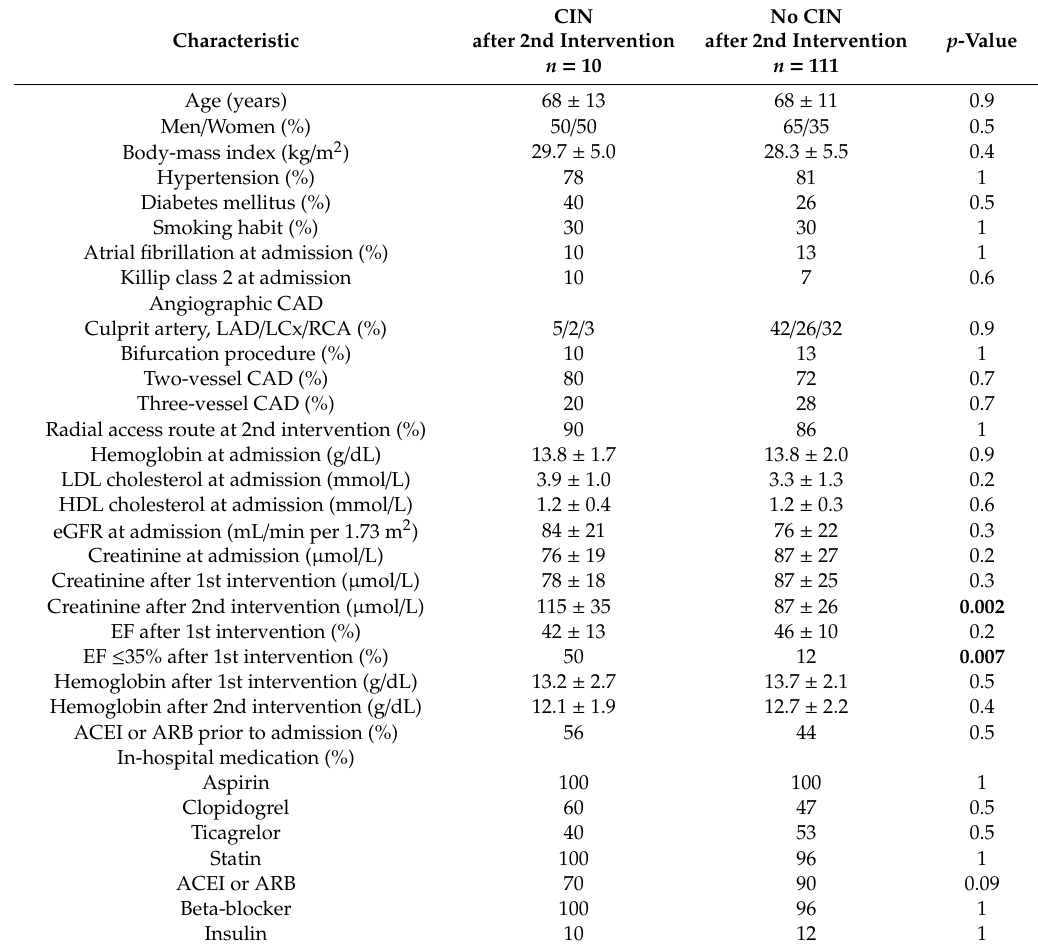
Table 1. Characteristics of patients with and without contrast-induced nephropathy (CIN) after the second step of staged complete coronary revascularization during hospitalization for acute myocardial infarction